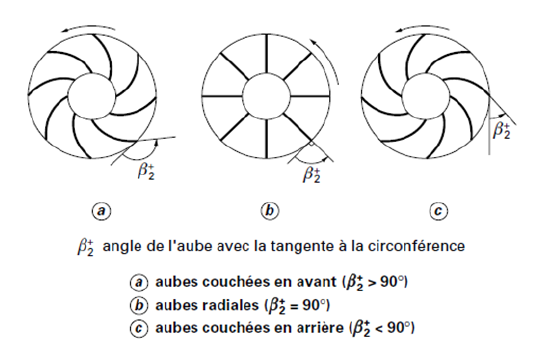
Figure 2: Various blade shapes of a mobile compressor